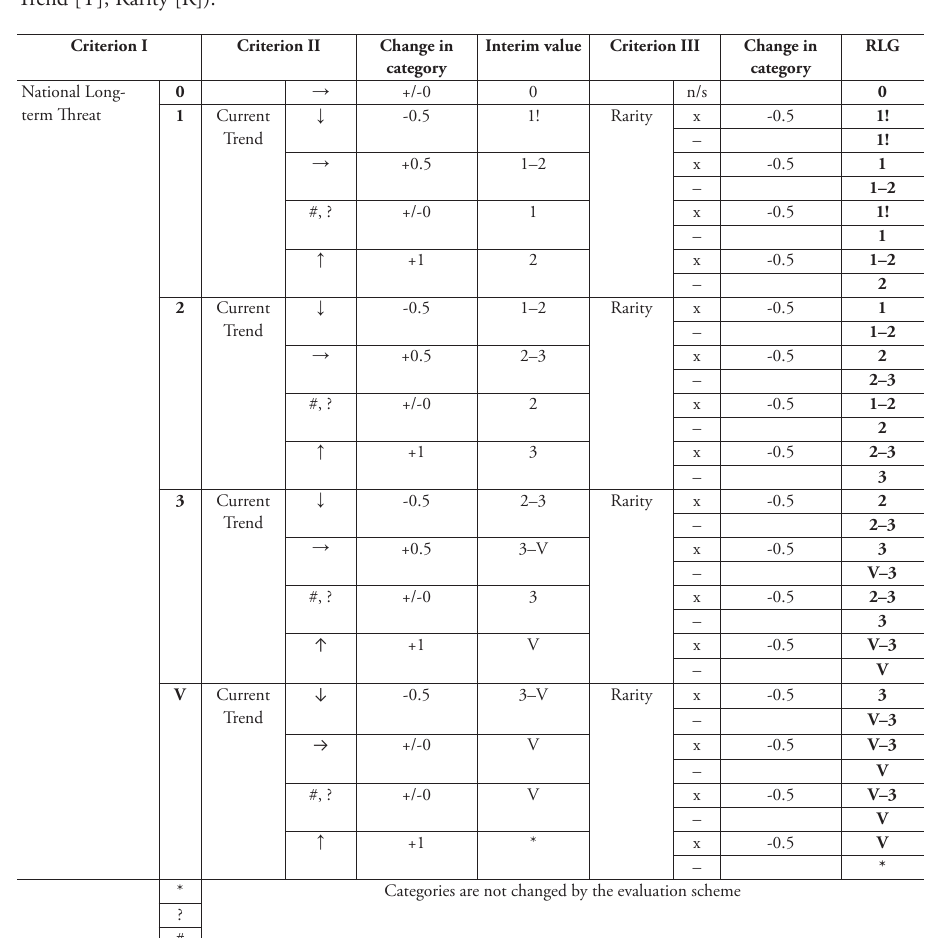
Table 3. Assessment scheme for determining the German Red List status (RLG). For the overall classifi- cation, three criteria are applied stepwise from left to right (National Long-term Threat [nTH], Current Trend [T], Rarity